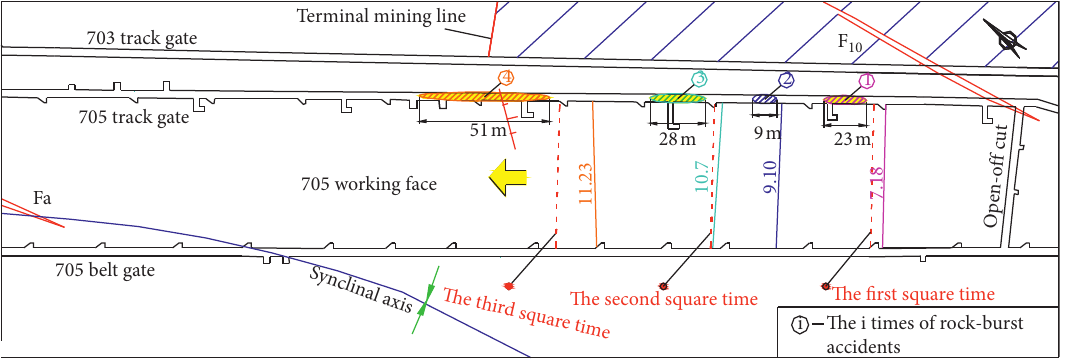
Figure 2: Relation between the position of No. 705 working face and the corresponding 5 times rock burst